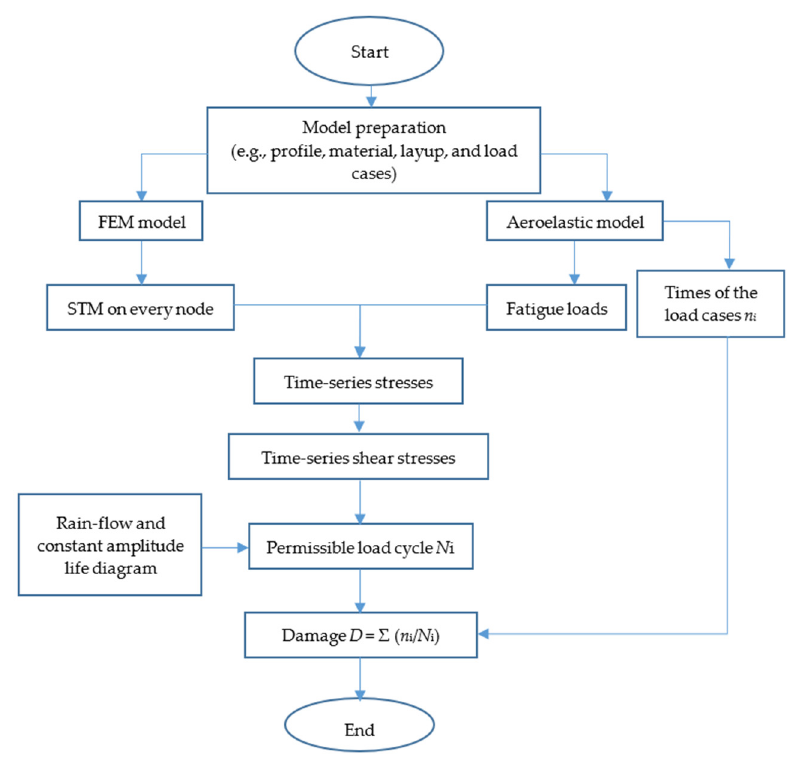
Figure 12. Flow chart of the calculation process of damage.